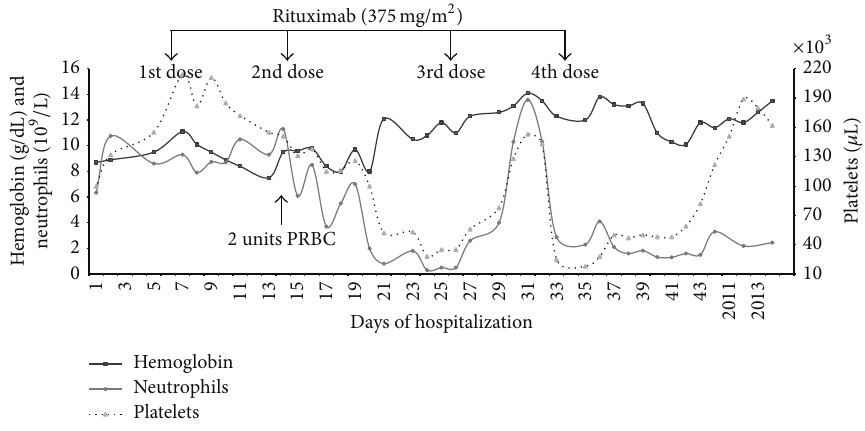
Figure1:Hemoglobin,neutrophilcount,andplateletcountduringhospitalization.Markeddecreasesinneutrophilsandplateletsareobserved after seven days of the second rituximab infusion. Hemoglobin levels increased eight days after the second rituximab infusion and remained hemoglobin, neutrophil count, and platelet count remained